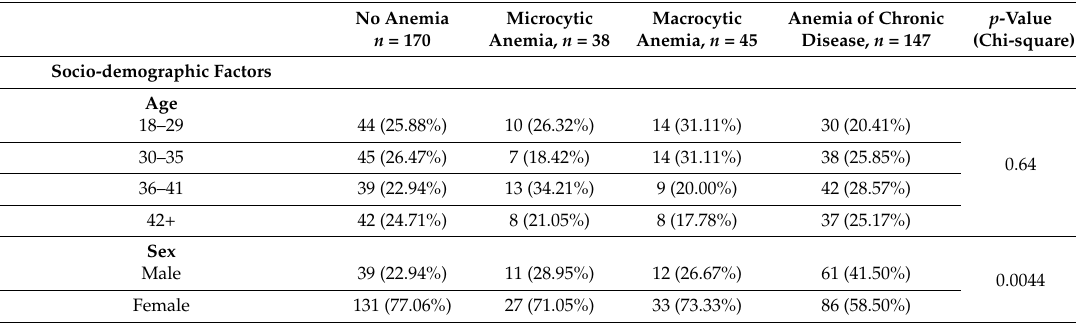
Table 1. The description of Study Base by Type of Anemia present at enrollment in HIV-infected Ugandan Adults.